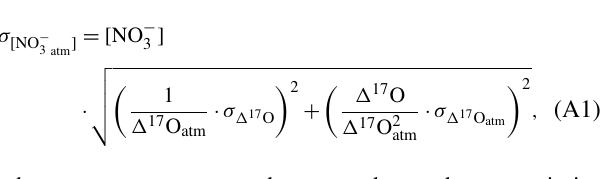
equation of error propagation (Eq.